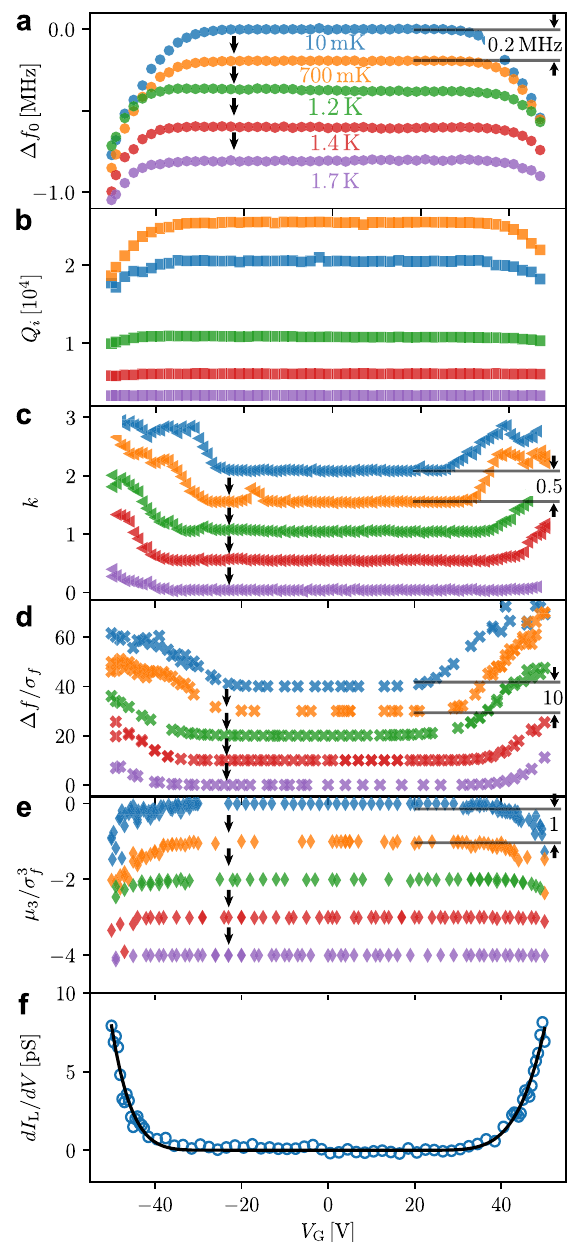
Fig. 4 Summary of the gate dependencies for all measured quantities at different temperatures. Colours represent the cryostat temperature, which is common across all panels. For clarity, curves have been equidistantly shifted from each other, shown by the black arrows, by the value shown in black on the right of the corresponding panel. a The shift of the resonance frequency; b internal quality factor; c exponent k of the noise PSD ∝ f − k ; d normalised frequency shift, and e normalised 3rd moment (skewness) of the frequency fl uctuations. f Measured differential conductance d I L /d V G of the gap between the gate and Dayem bridge overlapped with a fi t obtained using Eq.